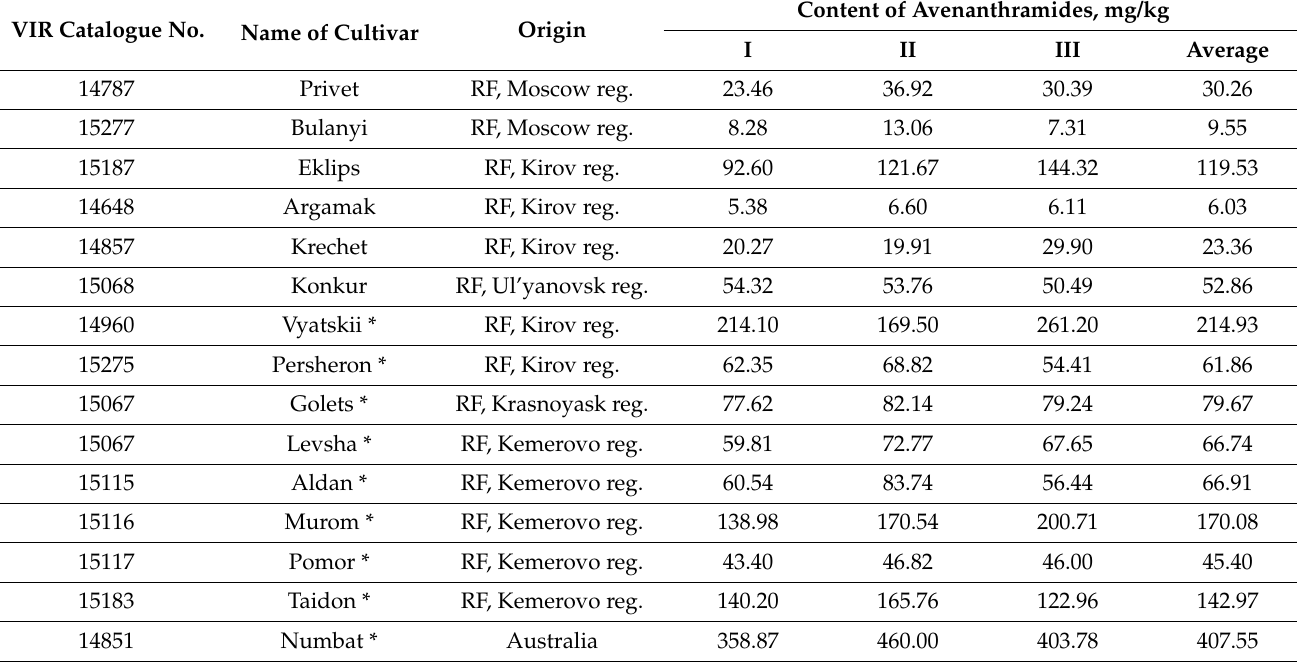
Table 2. Content of avenanthramides in oat cultivars